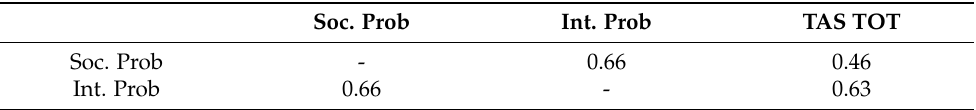
Table 5. Pearson’s r correlations between the TAS-20 total score and the social problems and internal- izing problems scales of the